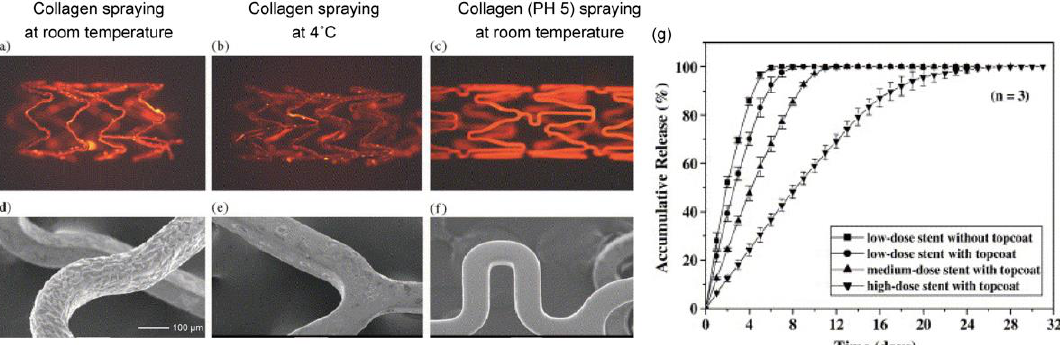
Figure 10 . Fluorescence microscopic images and SEM micrographs of metallic stents spray-coated with collagen using different processes. ( a , d ) Neutral aqueous collagen spraying at room tempera- ture; ( b , e ) neutral aqueous collagen spraying at 4 °C; and ( c , f ) aqueous collagen (pH 5.0) spraying at room temperature. ( g ) Cumulative release profiles for sirolimus from different types of the siro- limus-loaded stents. Adapted with permission from [75]; published by Elsevier,